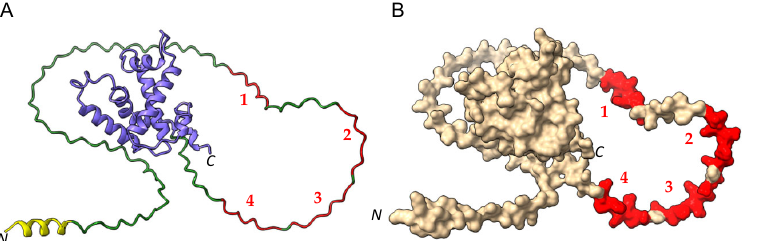
Figure 4. Ribbon diagram ( A ) of the three-dimensional model retrieved from the AlphaFold Protein Structure Databank (https://www.alphafold.com, accessed on 22 August 2022). The signal peptide, the disordered N -terminal domain and the α -helical C -terminal domain are colored yellow, green and violet purple, respectively. The four potential celiac peptides (1–4) are colored red. ( B ). Molecular surface of the three-dimensional model (colored sand), showing the exposure of the four potential celiac peptides 1–4 (colored